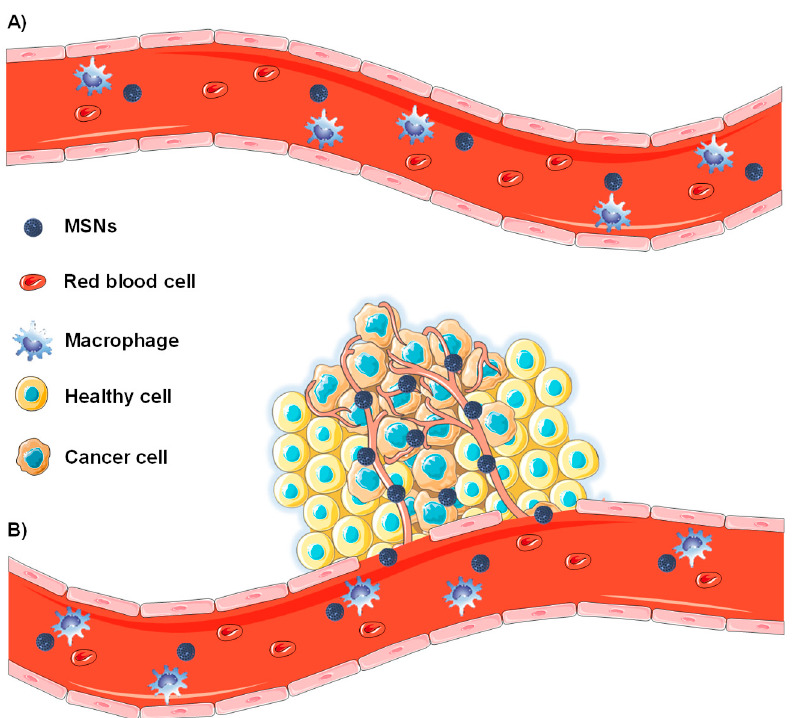
Figure 2. Schematic representation of the enhanced permeability and retention effect. ( A ) Normal blood vessels do not present fenestrations and MSNs remain in the bloodstream. ( B ) Tumor tissues present defective blood vessels and MSNs can leak out from them through the endothelial gap-gap and accumulate in the tumor.